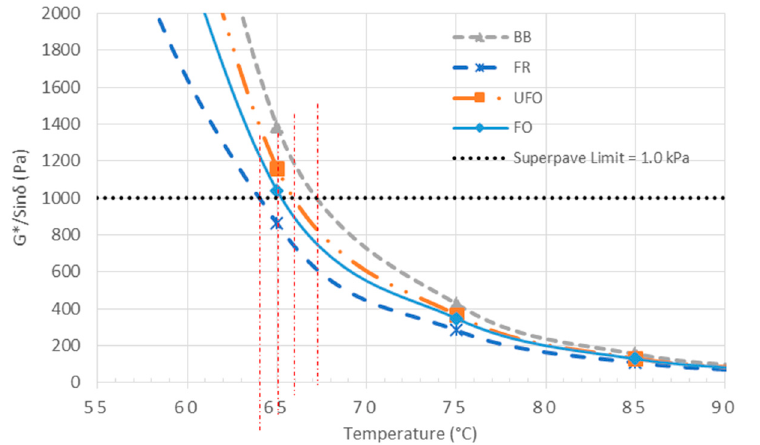
Figure 7. Effect on low temperature stiffness of asphalt binders at 10 rad/s for ( a ) unaged and ( b ) RTFO aged.